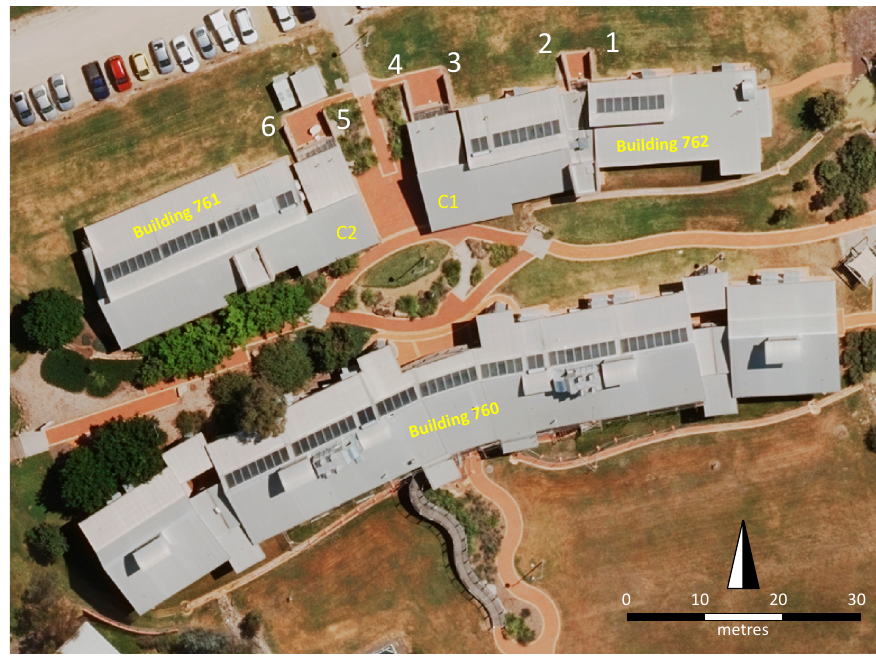
Figure 6. The School of Environmental Sciences building complex, Charles Sturt University, Thur- goona, showing the location of the buildings and the eight walls under discussion (1–6, C1, C2). Base image: Google Earth.